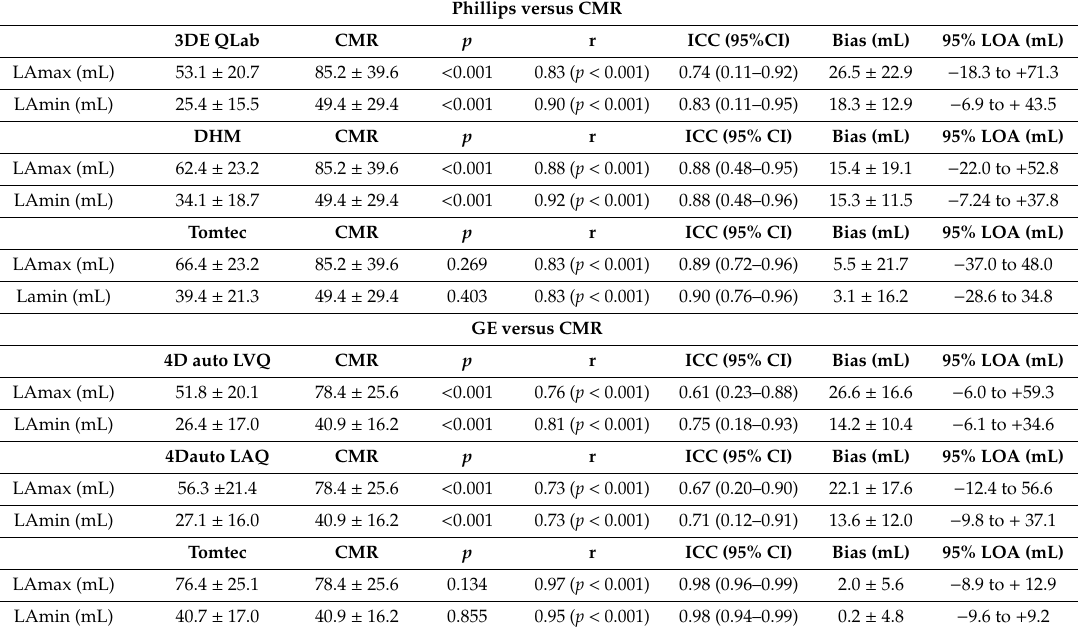
Table 5. Comparison between di ff erent three-dimensional echocardiographic modalities and cardiac magnetic